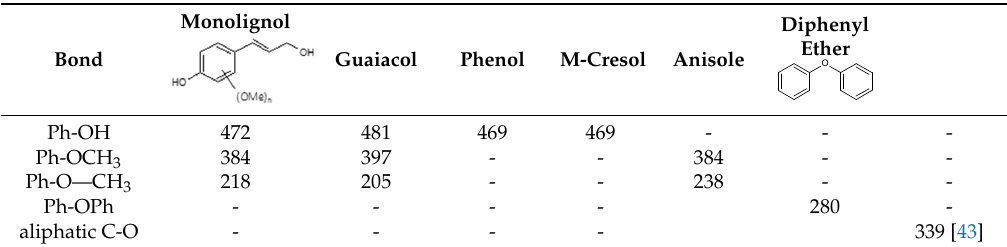
Table 3. Homolytic bond dissociation energies for lignin derived model molecules calculated by B3LYP/6–311 G(d,p) level theory at 320 °C in the gas phase adapted from reference [36] and comparison with other bond dissociation energies from the literature. Bond dissociation energies are given in kJ/mol.